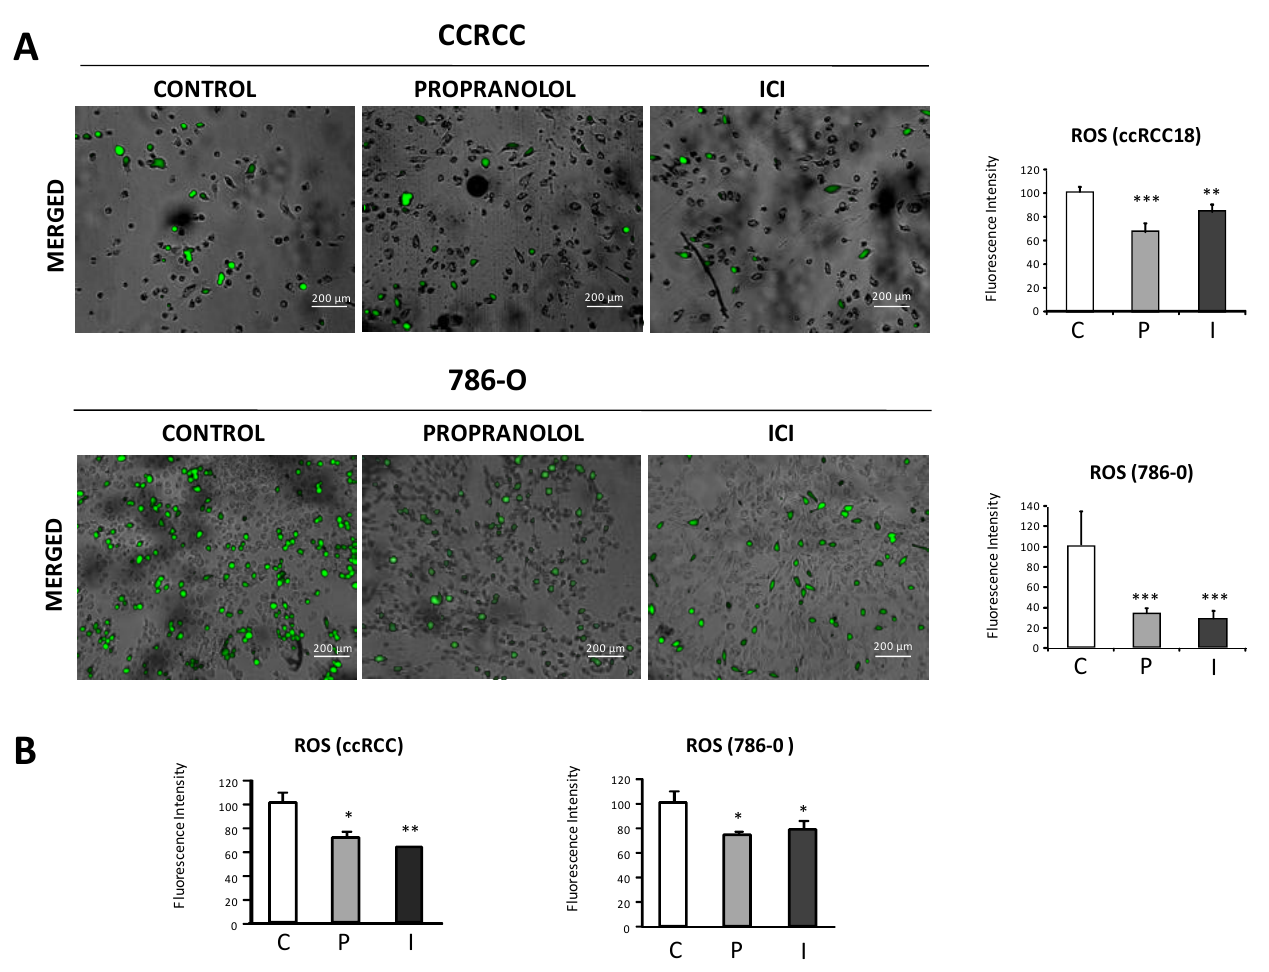
Figure 2. Effect of the β -blockers propranolol and ICI-118,551 on ROS levels in primary cultures of VHL-ccRCC and 786-O cells: ( A ) Brightfield and fluorescence microscopy merged images of VHL-ccRCC and 786-O cells showing the ROS expression after [0–50 µ M for 786-O and 0–100 µ M for ccRCC] propranolol or ICI-118,551 treatment for 72 h. Quantification of fluorescence intensities (485/535 nm) normalized to total cellular number. For quantification procedures, 12 different optic fields were taken from four replicates per condition; ( B ) The decrease in ROS species was also measured quantitatively by fluorescence, as explained in Material and Methods section. All data are based on three independent experiments. Scale bars represent 200 µm. Error bars denote ± SEM.